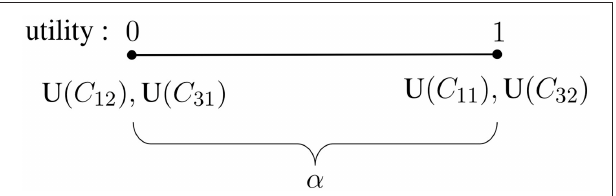
FIGURE 1 | Representation of the utilities for the best decision consequences, correct identification ( C 11 ) and correct exclusion ( C 32 ), assigned as 1, and the worst consequences, false identification ( C 12 ) and false exclusion ( C 31 ), assigned as zero. The utility that remains to be elicited is α , the value assigned for the consequences of reporting “inconclusive,” C 21 and C 22 . It can take any value in the range between 0 and 1 (including these endpoints).